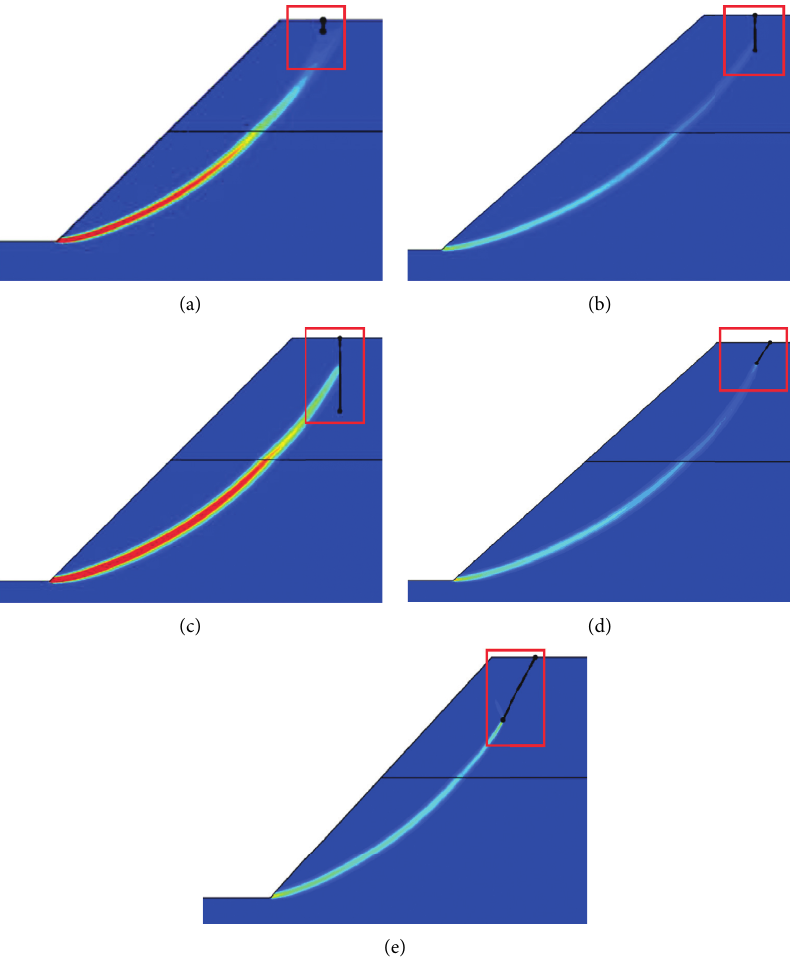
Figure 16: Failure mode of slope at different crack depths. (a) L/H � 0.05. (b) L/H � 0.10. (c) L/H � 0.15. (d) L/H � 0.20. (e) L/H � 0.25.